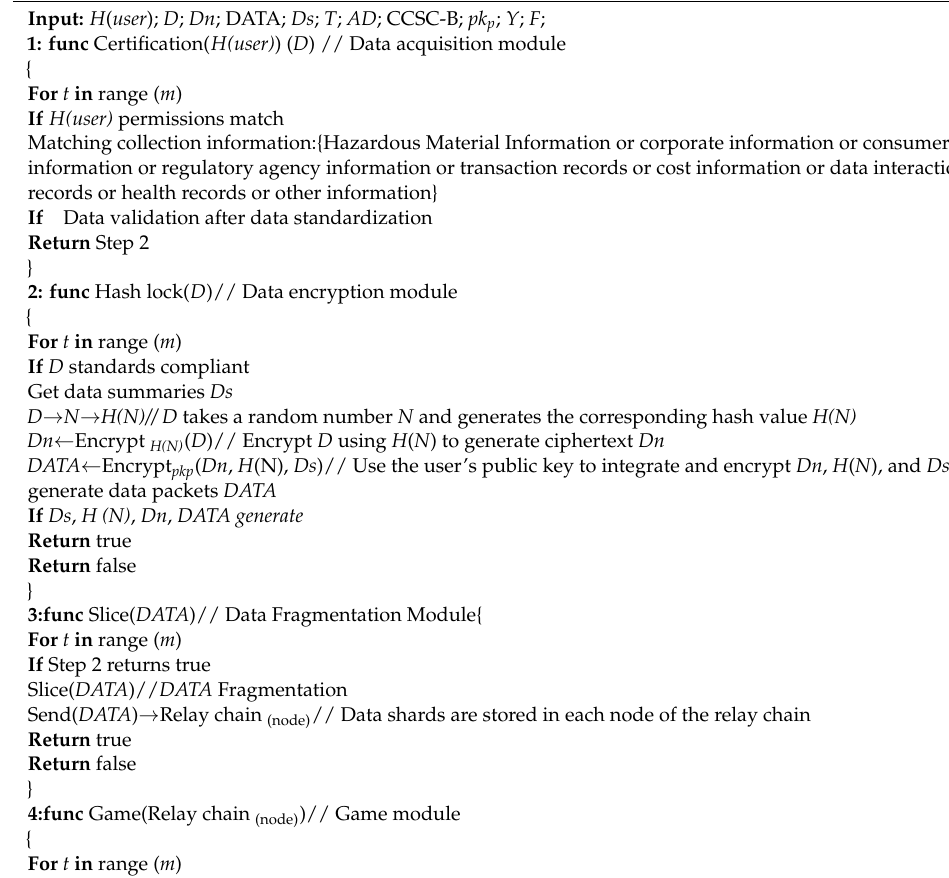
Algorithm A1: Collect cross-chain smart contract